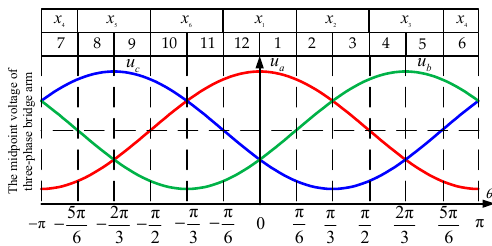
Figure 3. Terminal voltage for each phase. To reduce the DC-side current ripple for a CSC, Guo et al. [21] proposed the non- nearest three-vector ( i n , i n +1 and i n +2 , n = 1, 2, ..., 5) synthesis reference vector scheme. Tak- ing the sector 1 as an example, the reference vector I ref is synthesized through the non- nearest three vectors i 1 , i 2 and i 3 , and the dwell times of the three vectors can be calculat- ed according to the principle of the ampere-second balance. In the odd (1, 3, 5, 7, 9, 11) sectors, the dwell times for the three vectors are: